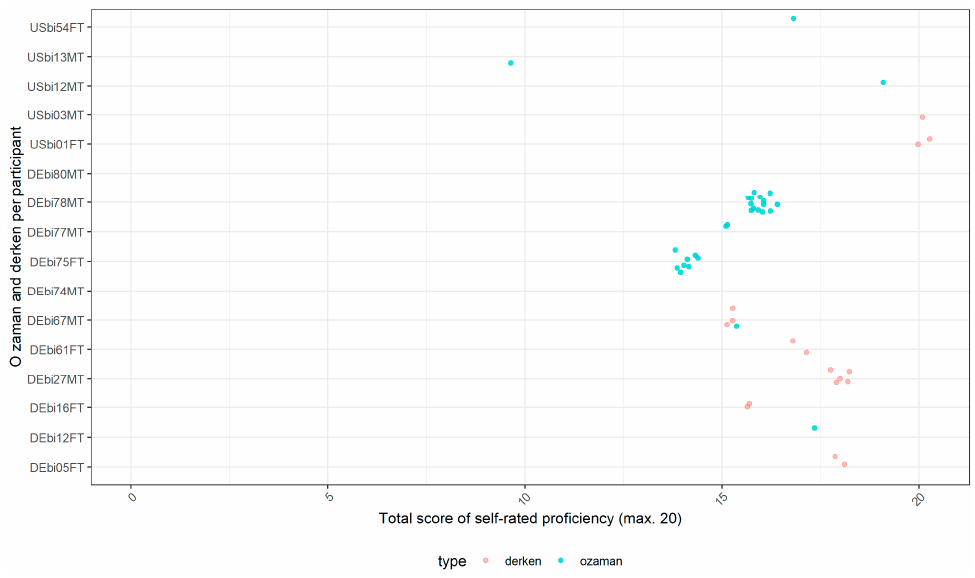
Figure 8. Jitter plot showing the total score of self-rated proficiency per participant regarding their uses of o zaman and derken.